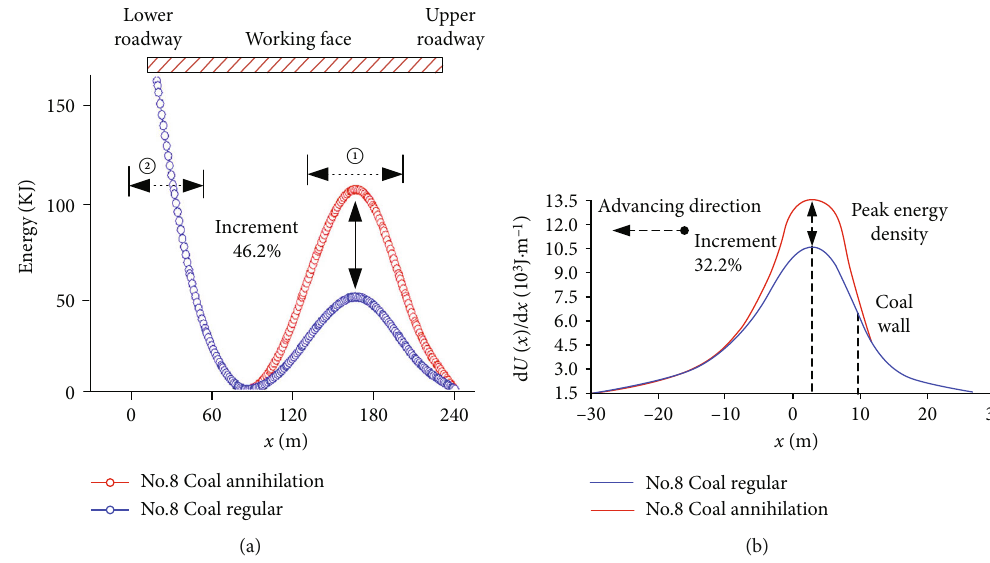
Figure 16: Schematic diagram of the energy increase of the tilted overhang structure in the stress anomaly zone: (a) inclined section of the working face; (b) strike direction of the working face.